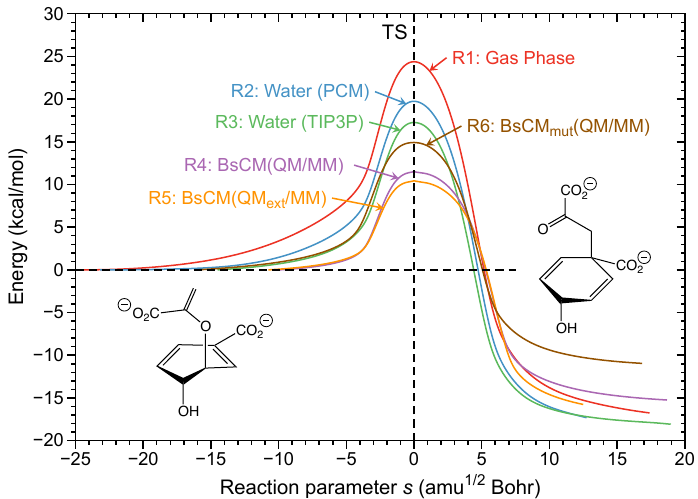
Figure 9. Energy profile of the chorismate rearrangements in the gas phase ( R1 ), aqueous solution modeled with PCM ( R2 ), modeled with TIP3P ( R3 ), in BsCM ( R4 ), in BsCM with an extended QM part ( R5 ), and in mutated BsCM ( R6 ). B3LYP/6-31+G(d,p), B3LYP/6-31+G(d,p)/TIP3P and B3LYP/6-31+G(d,p)/AMBER calculations. (Reprinted with permission from [118]; copyright 2020 from Taylor and